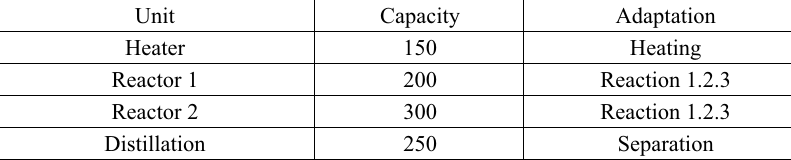
Table 2. Reactor